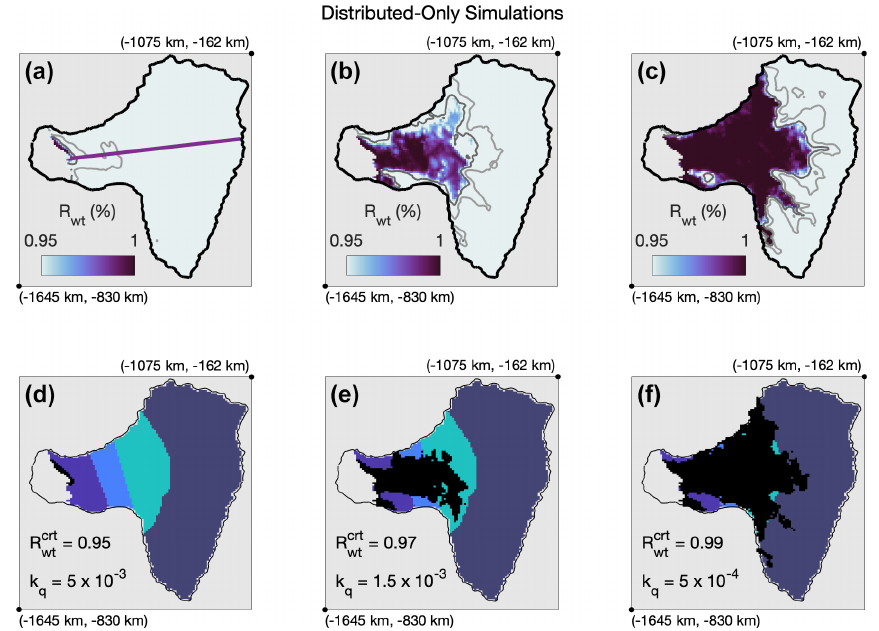
Figure 7. Three typical (a–c) R wt configurations and (d–f) coinciding binary masks (black) for distributed-only runs. Masks depict regions where R wt is above its threshold value, and thus the distributed system is at or above its capacity. R wt in distributed-only runs generally resembled one of these three patterns. Light and dark gray lines in (a) – (c) are the 50% and 90% R wt contours, respectively. Color-coding in (d) – (f) corresponds to the same zones as in Fig. 3. Purple line in (a) is the center-line transect used in Fig. 8. k q values used in each run, along with the R crt wt used to create the coinciding binary mask, are provided in (d) – (f) . All three runs had bed roughness parameters W r = 0 . 1m and c s = 0 . 5m − 1